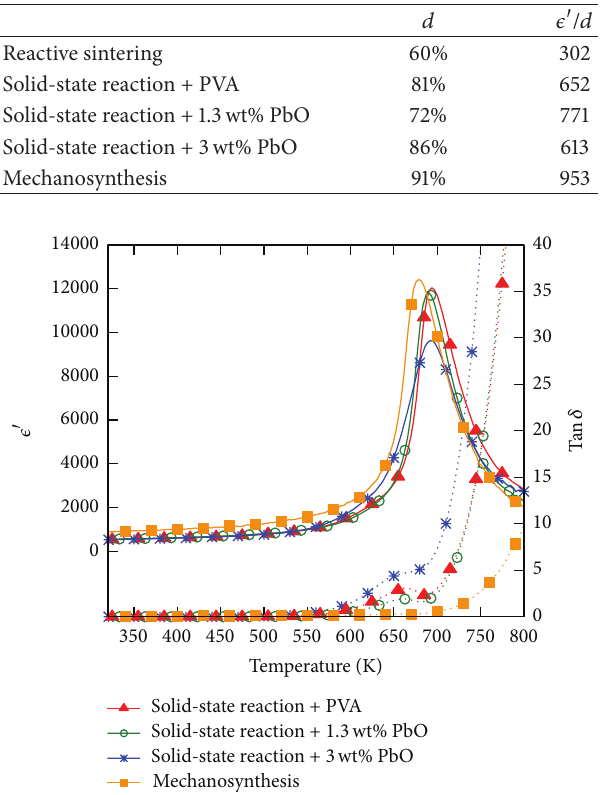
Figure2:Realpartofthedielectricconstant 𝜖 󸀠 (line)andlossestan 𝛿 (dotted line) of PYN-PT with 60% PbTiO 3 measured at 1kHz and as a function of temperature on ceramics obtained by various synthesis techniques: +PVA, +1wt% PbO, and +3wt% PbO designate the binder used with powders obtained by the solid-state technique. All samples were sintered at 950 ∘